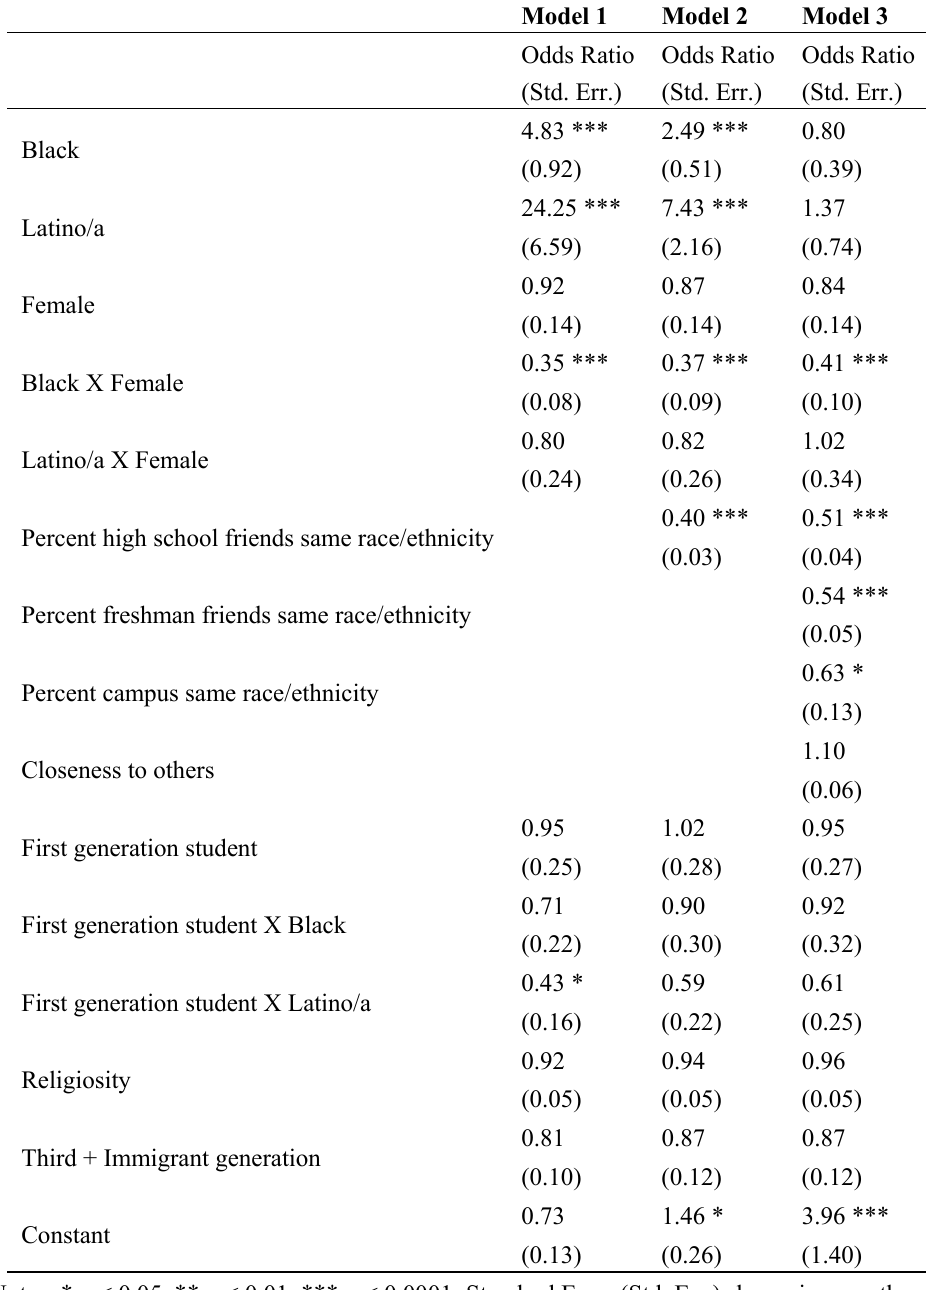
Table 3. Racial/ethnic gaps in intercultural dating, logistic